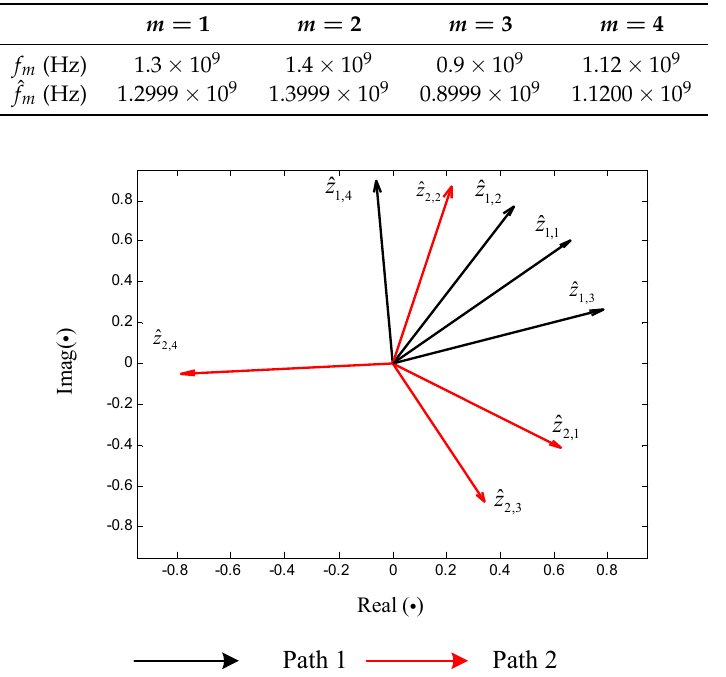
Figure 4. Clustering of uncorrected vector quantities.